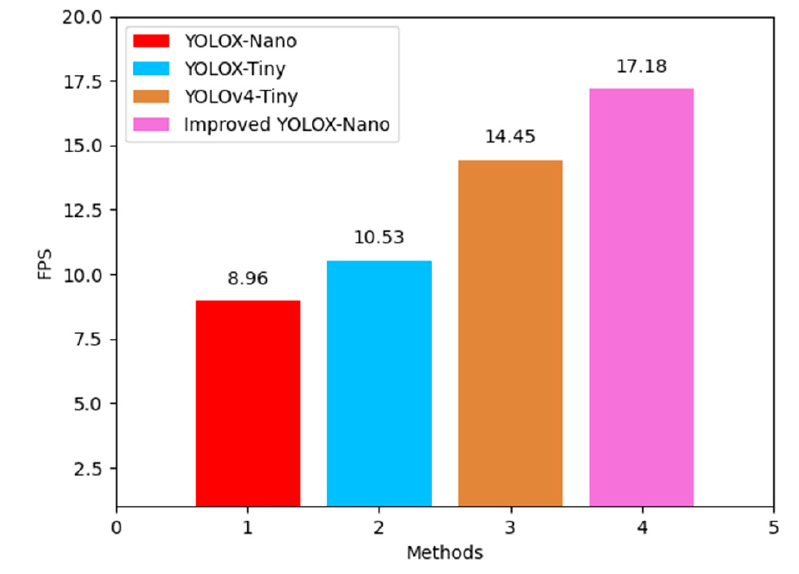
Figure 7. Speed of different detection